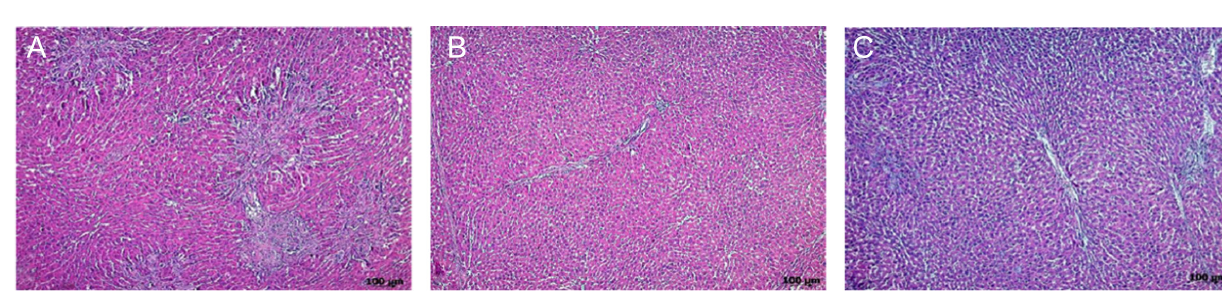
Figure 5. A comparison of liver histopathology in the BDL+CROM group with sham and control groups. (Light microscopic images of the liver tissue with hematoxylin and eosin staining are seen). (A) Liver damage caused by bile duct ligation in the control group. (B) Mild lobular and portal inflammation in liver tissue in the sham group. (C) Light microscopic images of the liver tissue in the BDL+CROM group with hematoxylin-eosin staining. BDL, bile duct ligation; CROM, cromolyn sodium.